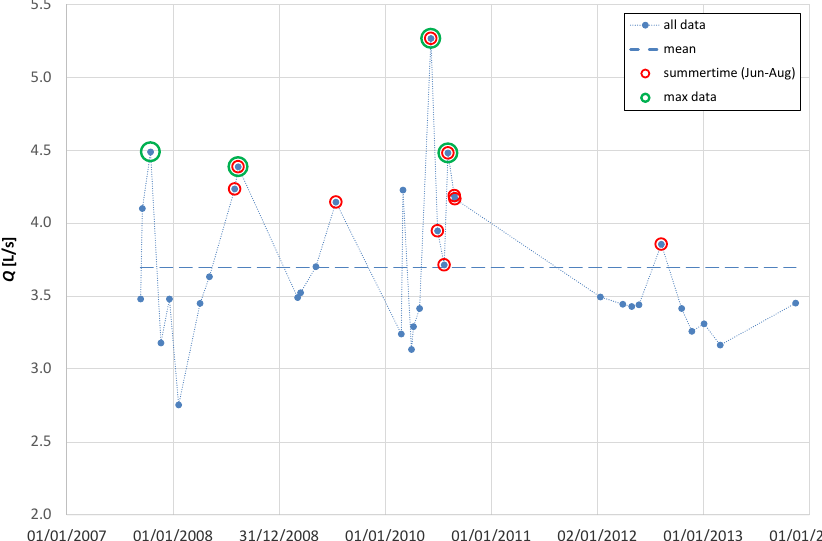
Figure 3. Daily mean water demand in Servigliano between 2007 and 2013 (blue dots). The mean value (blue line), summertime measures (red circles), and maximum collected data (green circles) are shown.